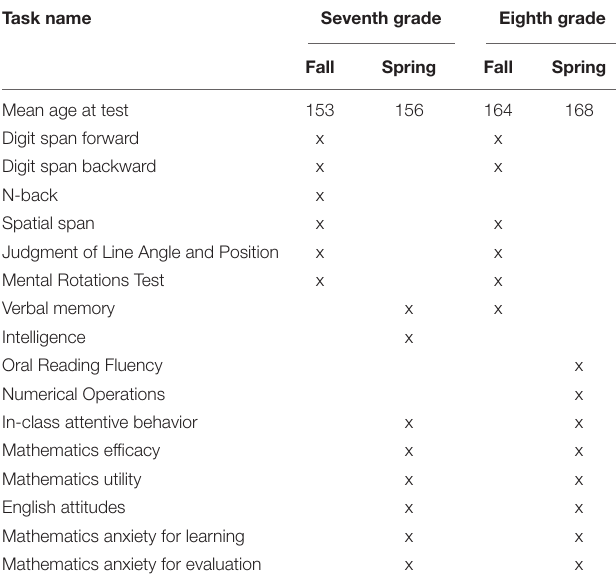
TABLE 1 | Age of administration and timing of